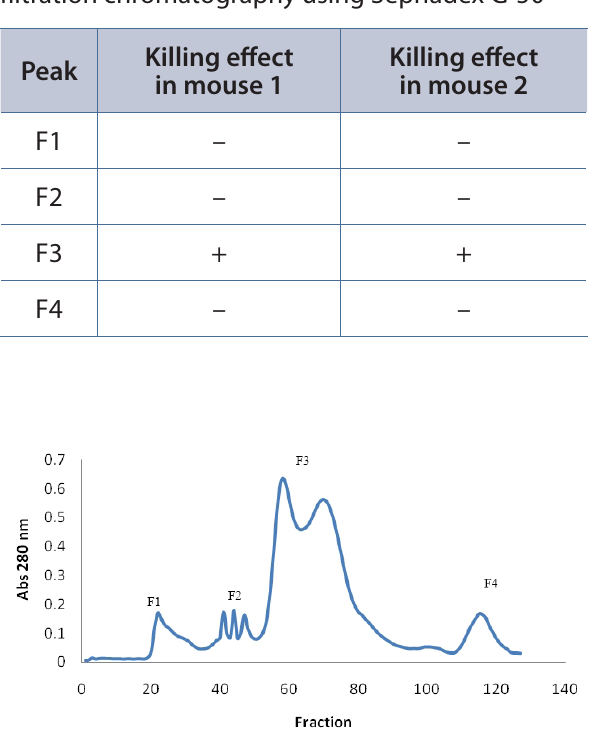
Figure 2. Separation of Mesobuthus eupeus venom by gel filtration chromatography.